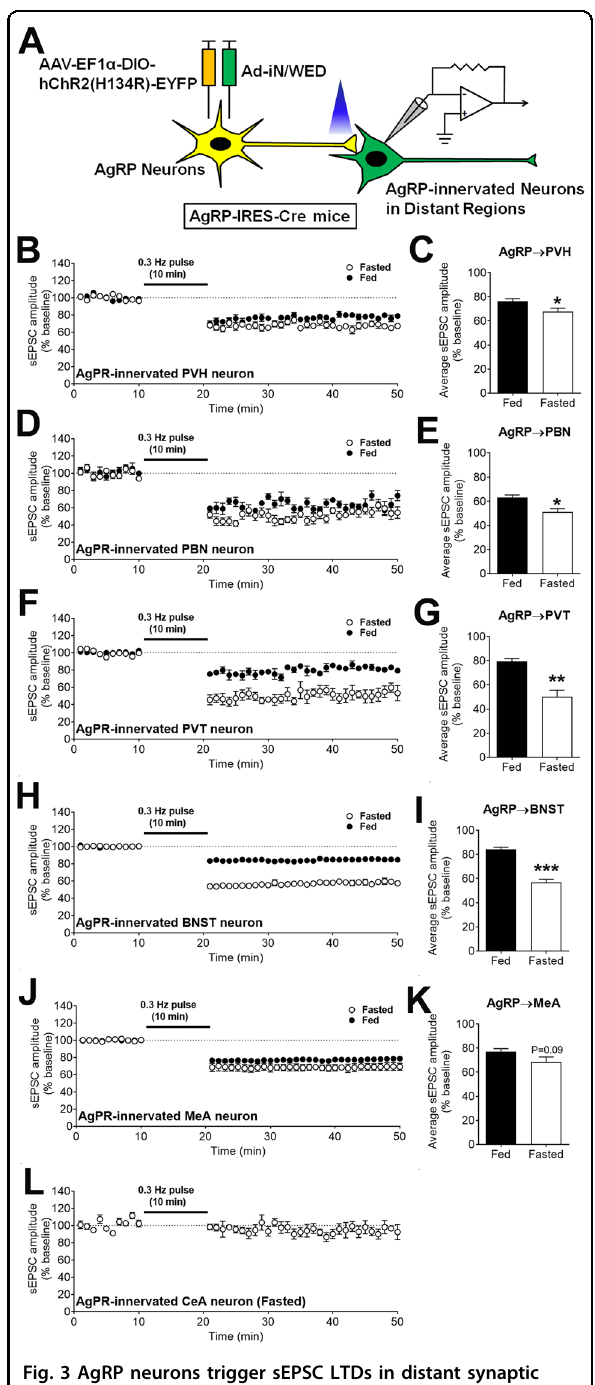
Fig. 3 AgRP neurons trigger sEPSC LTDs in distant synaptic targets. A Schematic illustration to identify distant AgRP-originated synapses. B , D , F , H , J , L Temporal changes in sEPSC amplitudes before and after the 10-min photostimulation in AgRP-innervated PVH ( B ), PBN ( D ), PVT ( F ), BNST ( H ), MeA ( J ), CeA ( L ) neurons from mice that were fed ad libitum or fasted for 24 h. C , E , G , I , K The average sEPSC amplitude after AgRP stimulation in AgRP-innervated neurons in ( B , D , F , H , J ), respectively. Data are mean ± SEM. n = 4, 5, 6, or 7 per group. * P < 0.05, ** P < 0.01, and *** P < 0.001 vs. fed group in two-tailed unpaired t tests. Also see Figs. S2 and